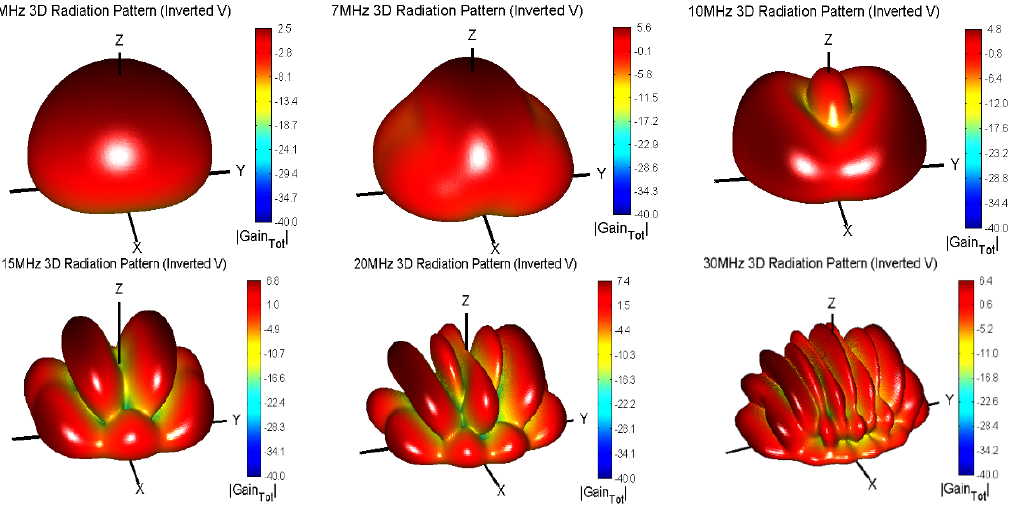
Figure 3. Three-dimensional radiation patterns of the inverted V dipole antenna for different oper- ating frequencies, in which the 3D radiation patterns at frequencies of 2, 7, 10, 15, 20, and 30 MHz are shown.